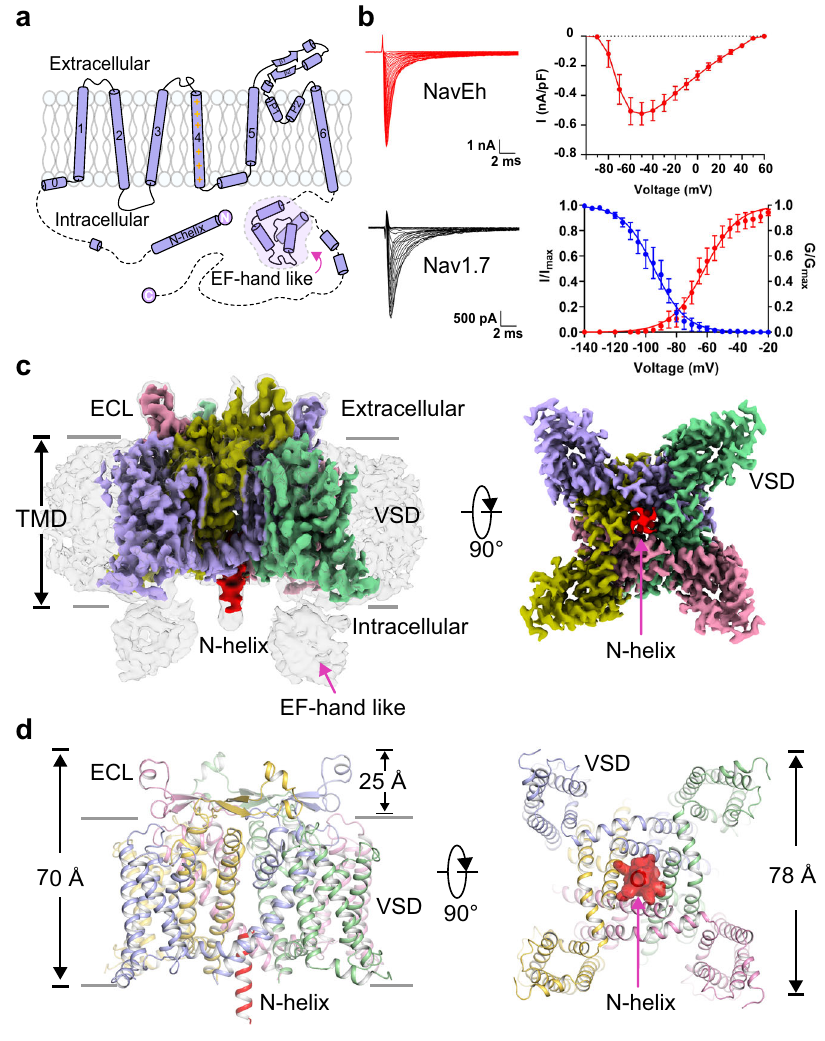
Fig. 1 Cryo-EM structure of Na V Eh. a Topology of Na V Eh. Red plus signs represent gating charges on S4 helix. The dashed lines indicate unsolved region. b Electrophysiological characterization of the Na V Eh. A family of sodium currents conducted by Na V Eh (red) and Na V 1.7 (black), respectively. Average peak current-voltage curve is shown (right top), where currents were normalized to cell capacitance. Normalized conductance-voltage (G/V) relationship (Red circles) and steady-state inactivation (Blue circles) of Na V Eh. For measuring current-voltage curve, currents were measured from Na V Eh transfected HEK293T cells with 100-ms depolarizing pulses between − 100 mV and 60 mV in steps of 10 mV from a holding potential of − 150 mV. For measuring G/V curve, currents were measured with 100-ms depolarizing pulses between − 100 mV and 20 mV in steps of 5 mV from a holding potential of − 150 mV. For measuring steady-state inactivation, prepulse potentials between − 140 mV and − 20 mV in 5 mV increments for 500-ms were applied and followed by a 50-ms test pulse at 0 mV. The Boltzmann fi tted data yielded activation V 1/2 = − 61.5 ± 2.1 mV ( n = 15) and steady-state inactivation V 1/2 = − 94.4 ± 2.1 mV ( n = 9). Data are mean + / − SEM. c The cryo-EM density map of Na V Eh. The four subunits and N-helix are colored in purple, yellow, pink, green and red, respectively. d Cartoon representation of Na V Eh. The N-helix is shown in half-transparent surface for the right panel viewed from intracellular side. Source data are